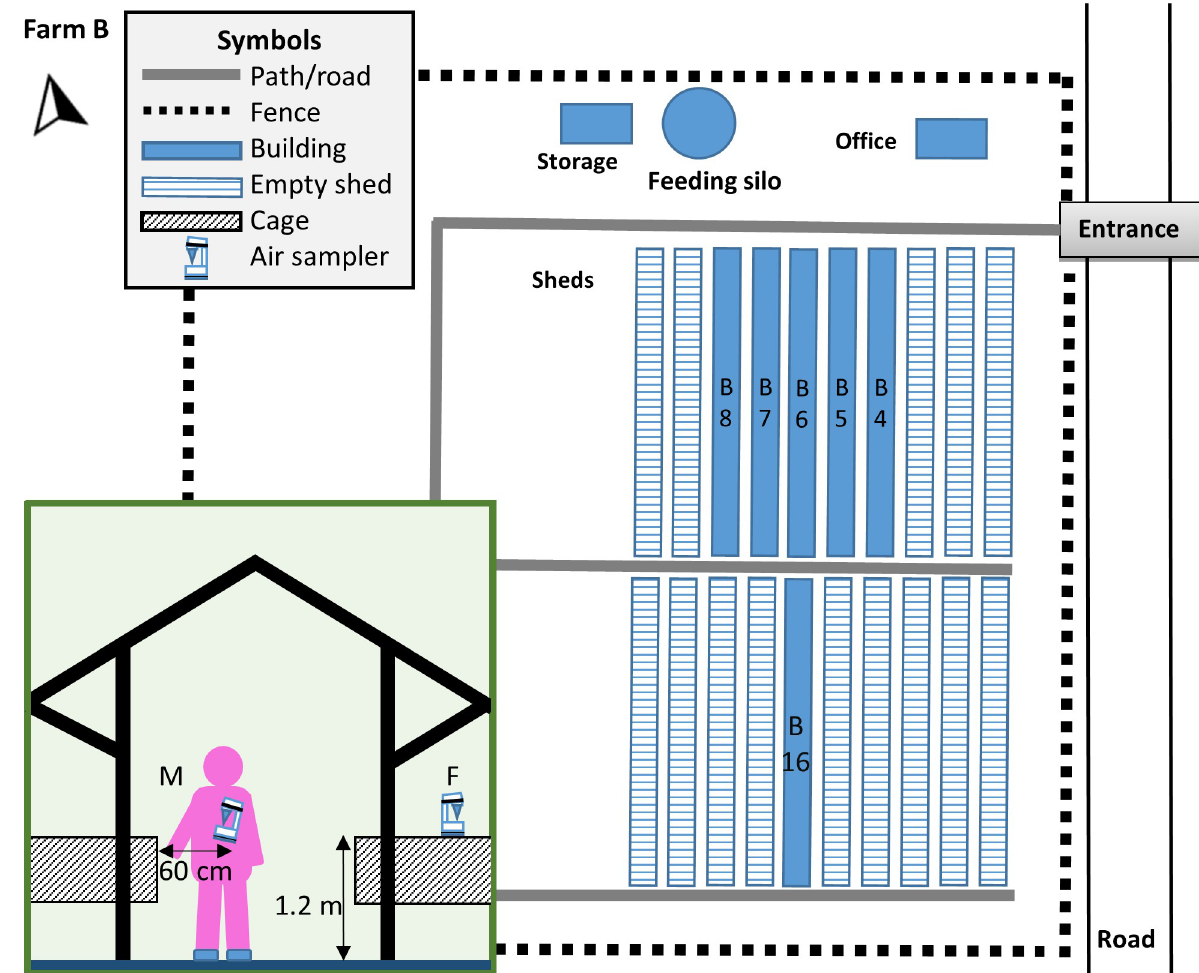
Fig 3. Floor plan of farm B. Animals were housed in sheds #B5-to-#B7. Sheds marked with dashed lines were empty throughout the investigation period and were not subjected to collection of environmental samples. Inset: cross section of the sheds indicating air sample collection with the microbial air sampler placed at a fixed (F) spot or being moved (M) during blood